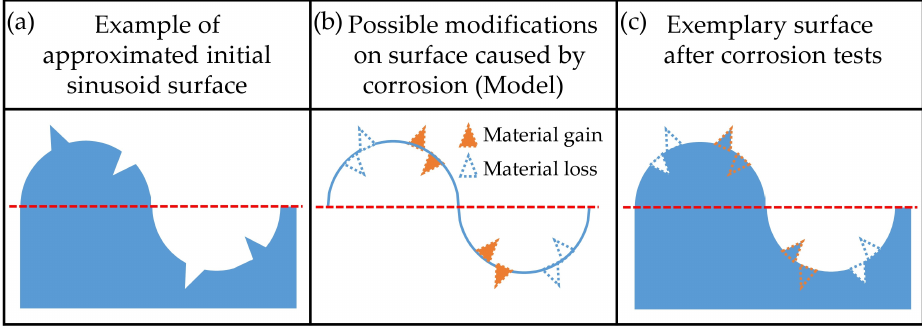
8Figure 8. Graphical presentation of the analysis performed for detection of corrosion effects on Figure surface topography: ( a ) approximated initial profile (before treatment); ( b ) possible corrosion effects and their locations; ( c ) profile of exemplary surface after corrosion.